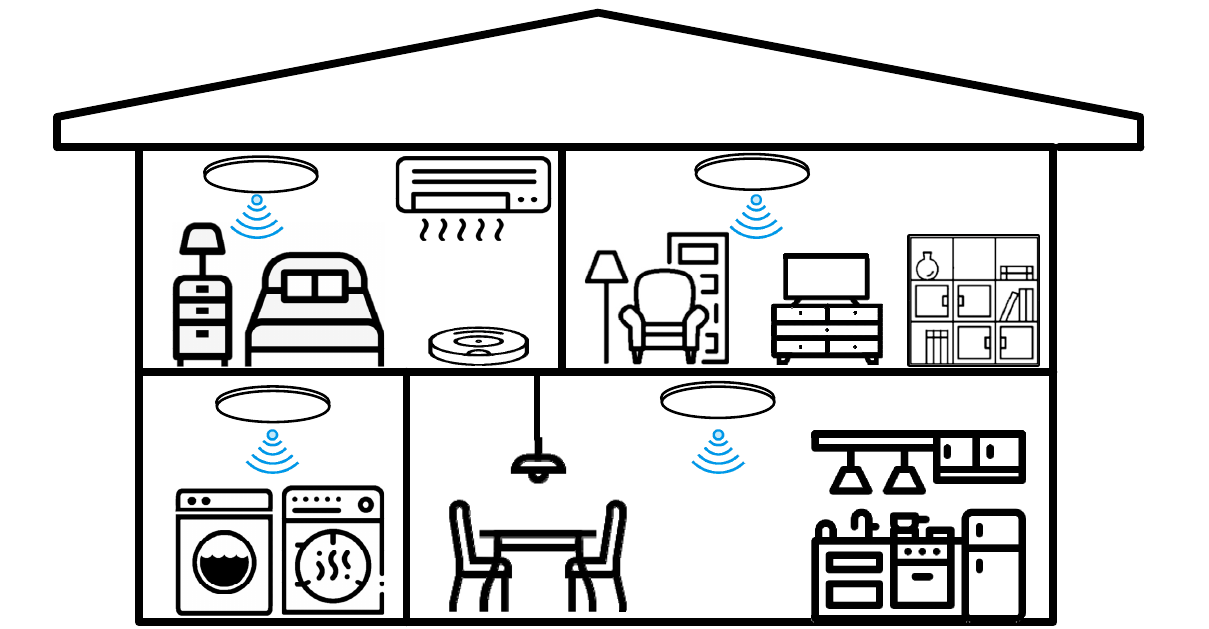
Figure 1. Environment of Wireless Sensor Node (WSN).